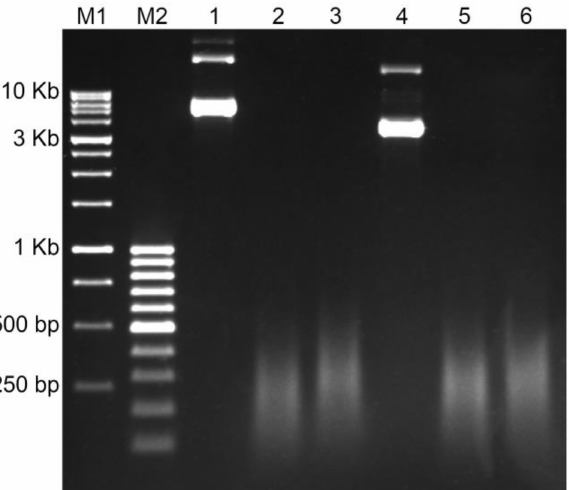
Figure 2. The results of the Nick translation of the plasmid DNA containing insert of the